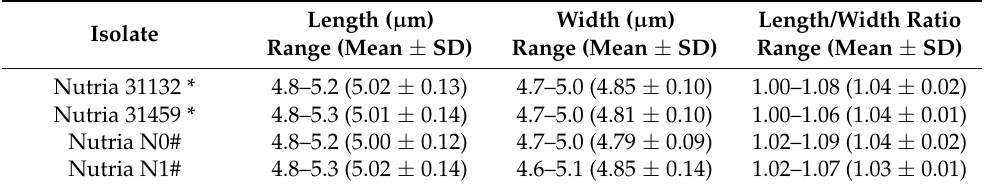
Table 2. Size of Cryptosporidium myocastoris n. sp. oocysts recovered from naturally * and experimen- tally # infected nutrias ( Myocastor coypu ).